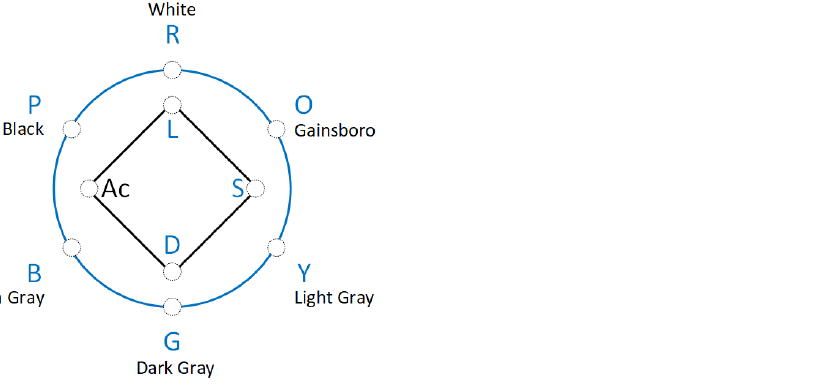
Figure 3. ColorWatch pattern for color hues and color tones. Blue and black text represents mono- chromatic and achromatic color modes,